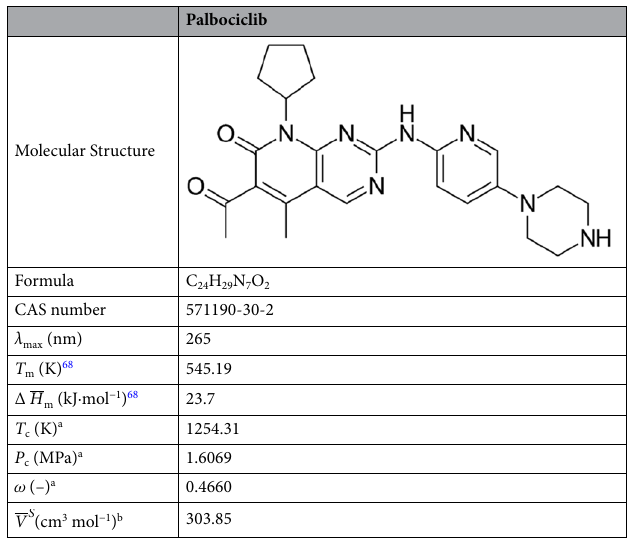
Table 1. Thermodynamic properties and molecular structure of palbociclib. a The values of T c and P c were estimated by PR + COSMOSAC EoS 70,71 and then rescaled by a factor of 0.88. The rescale factor is determined from regression of experimental solubility data together with k ij 78,79 . The Lee-Kesler equation 72 was used to estimate the acentric factor. b The molecular cavity volume in the COSMO solvation calculation was used as the solid molar